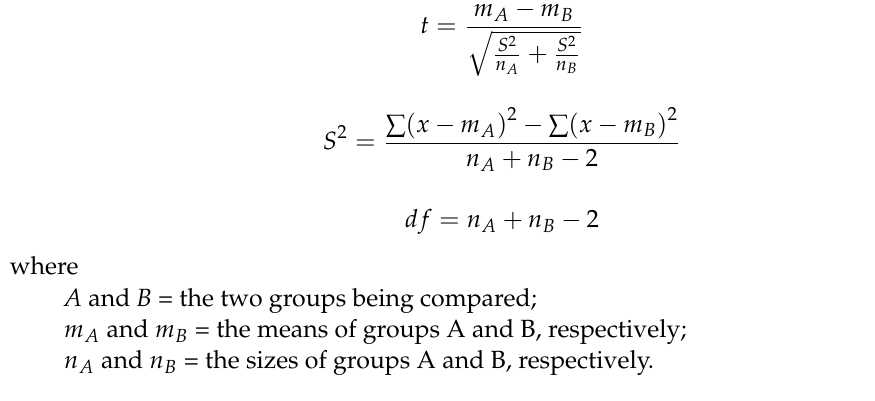
Table 1. Comparison of speed variances at conflict